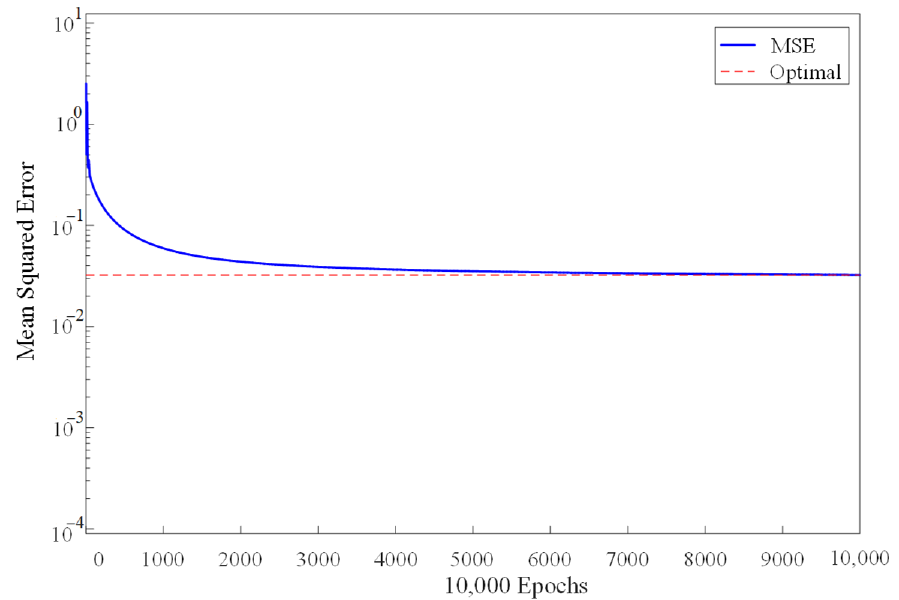
Figure 12. Convergence when training the model on desktop.